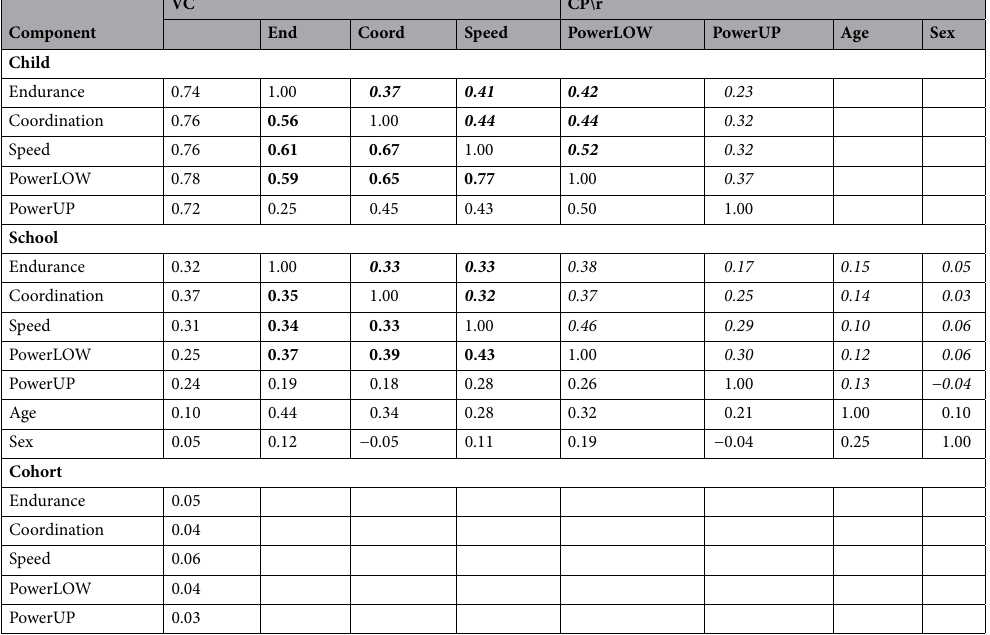
Table 2. Variance components, correlation parameters, and zero-order correlations for test scores. End = cardiorespiratory endurance (i.e., 6 min run test), Coord = star run test, Speed = 20-m linear sprint test, PowerLOW = power of lower limbs (i.e., standing long jump test), PowerUP = power of upper limbs (i.e., ball push test), VC = variance component, CP \ r = correlation parameter\zero-order correlation; linear mixed model correlation parameters are shown in upright and corresponding pairwise zero-order correlations are shown in italics for children (top) and schools (middle). Theoretically relevant correlations discussed in the text are set in bold. VC for Residual = 0.53. VCs and CPs are based on full set of data; ZOC correlations are based on subsets of data (Child: 96,529 children from 512 schools; School: 93,661 children from 421